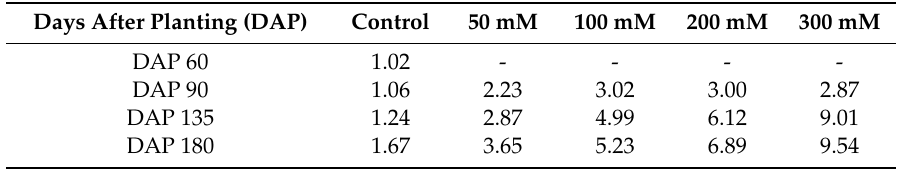
Table 1. The electric conductivity of the growing media (mS cm − 1 ) of the control, 50, 100, 200 and 300 mM NaCl treatments at di ff erent harvest dates. Days After Planting